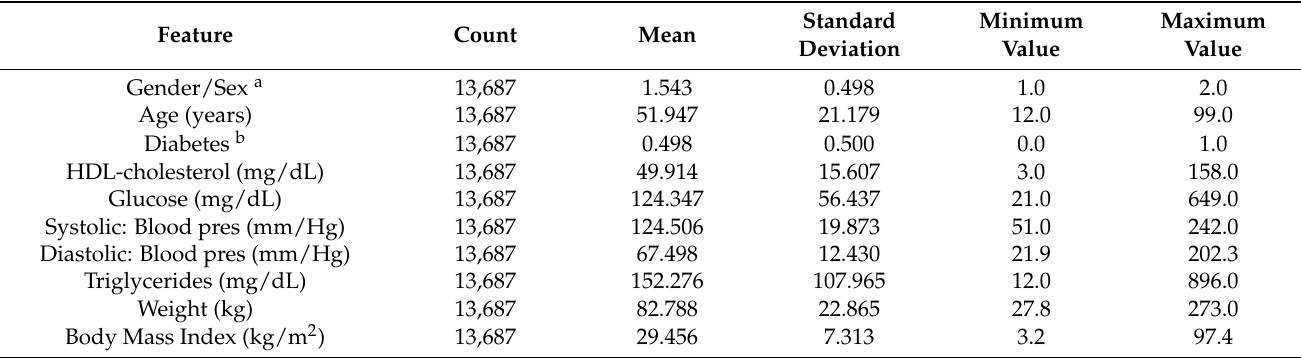
Table 2. Data statistics after the